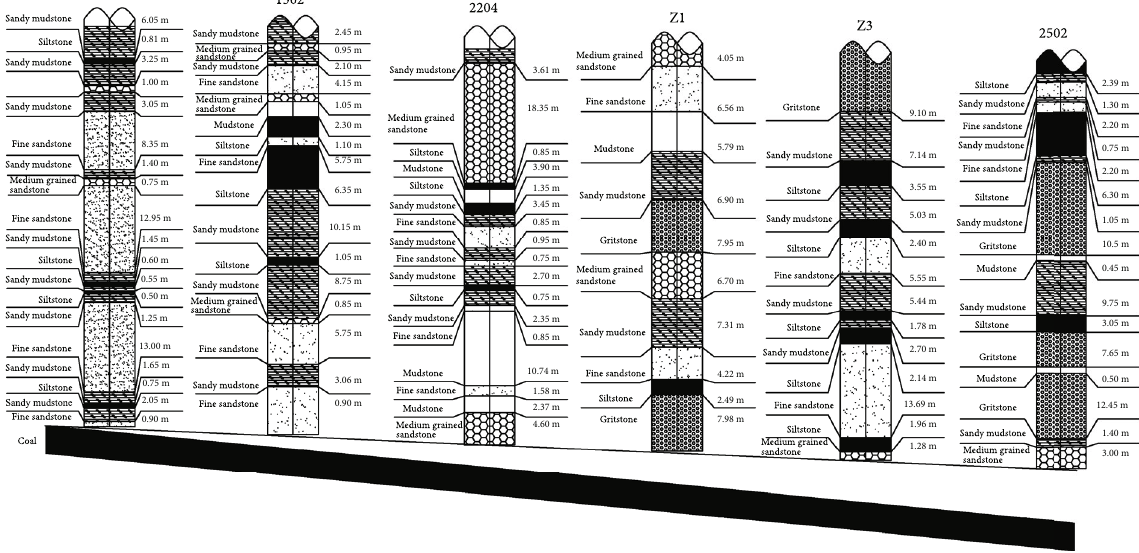
Figure 8: Part of borehole column of “ Qilizhen sandstone ” in Zhiluo Formation.